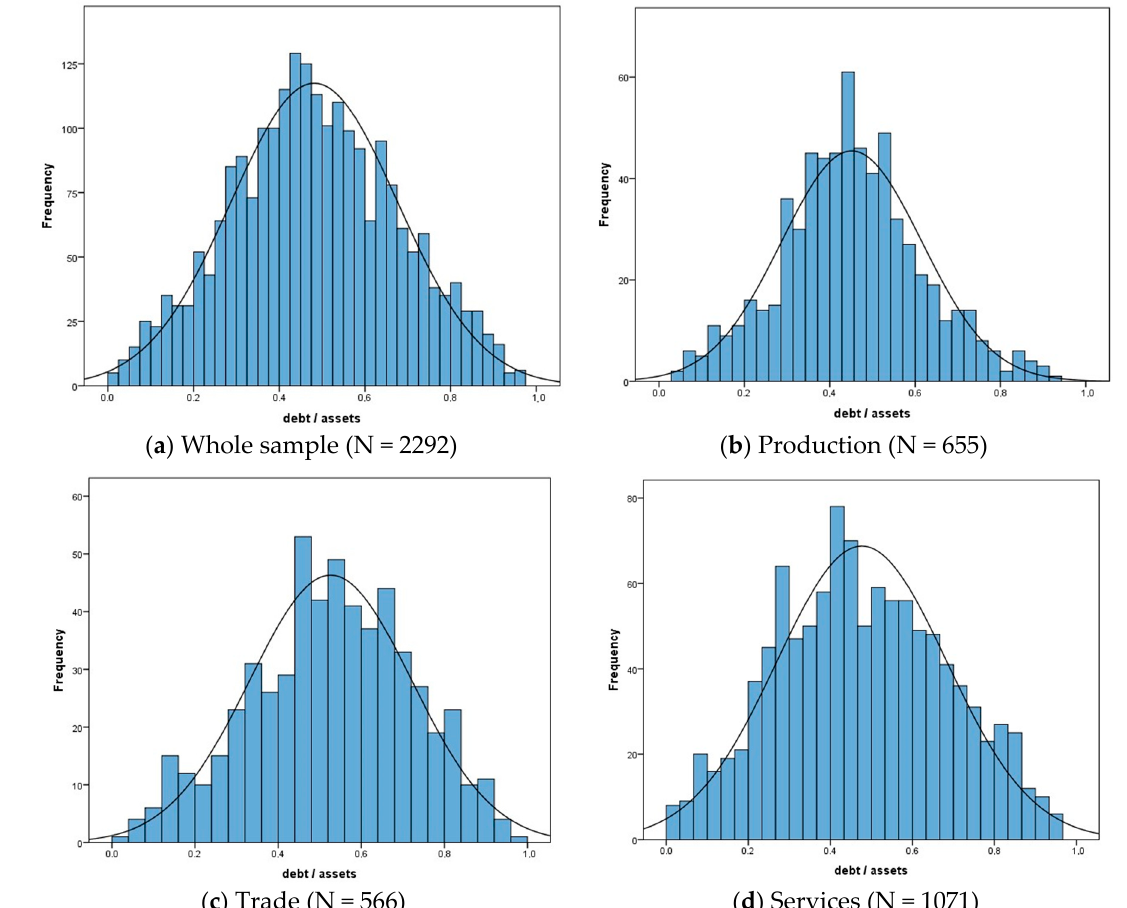
Figure A1. Distribution plots for liquidity constraints (Cash and cash equivalents to assets).